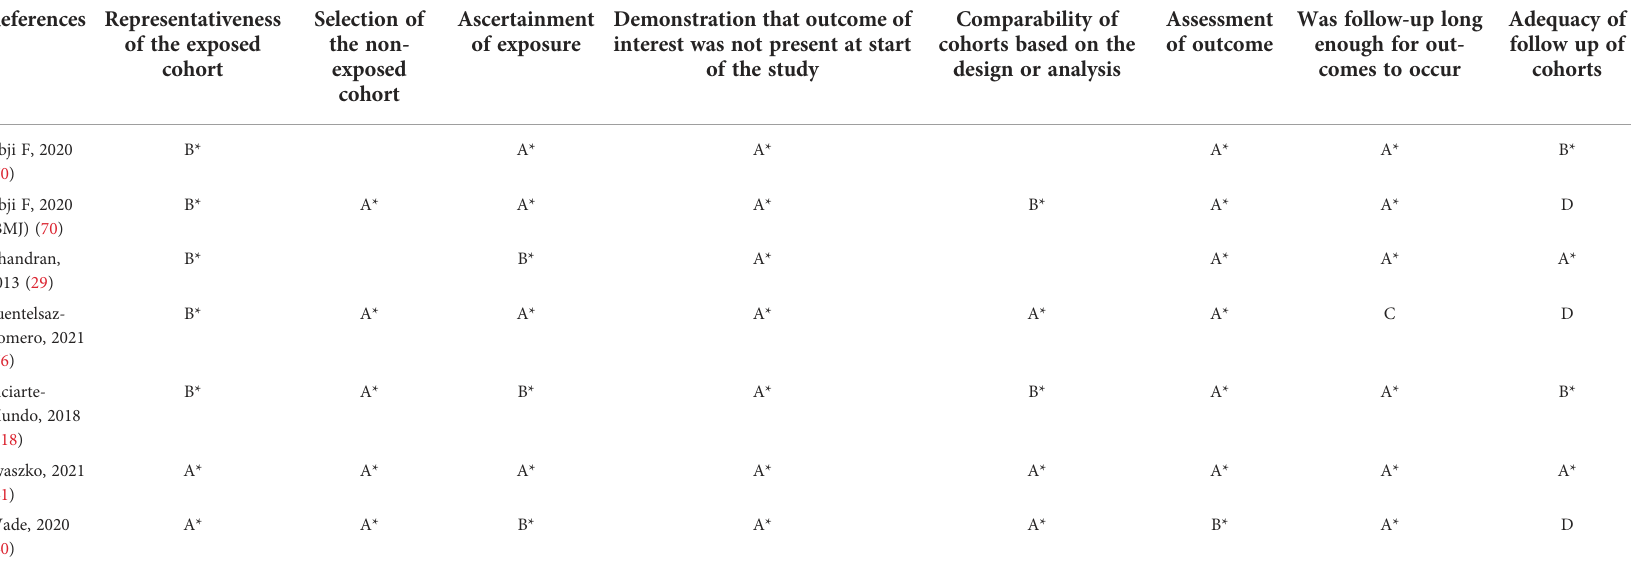
TABLE 4 Assessment of bias risk using NOS scale for cohort study. References Representativeness Selection of of the exposed the cohort